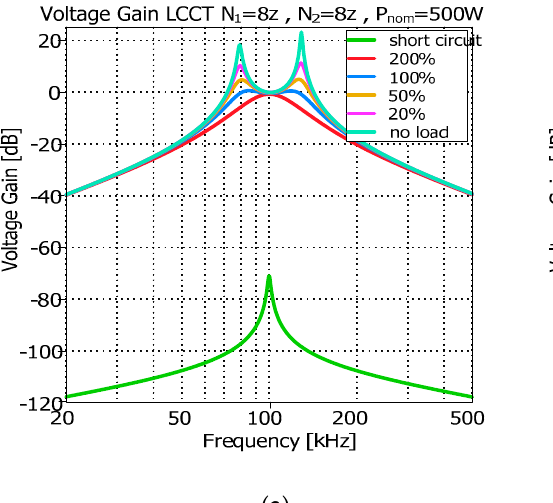
Figure 3. Impact of turn ratio on the voltage gain of resonant tank, ( a ) ratio 1:1, ( b ) ratio 1:0.25.